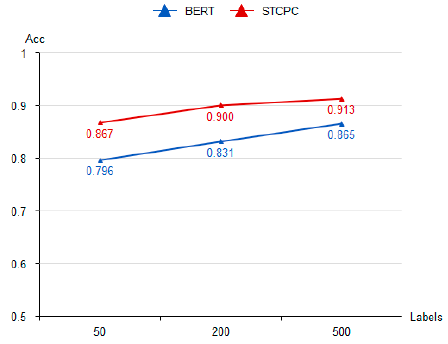
15 of 18 Figure 7. IMDb dataset training results. Figure 8. Amazon Reviews dataset training results. Figures 9 and 10 make a comparison of different numbers of classifications when the amount of unlabeled data is the same. It can be seen that the rising range of STCPC is not higher than that of the BERT model when the amount of unlabeled data is constant, and the number of classifications increases. Considering that this is because the increase in the number of classifications will increase the content of labeled data, whereas BERT, in this